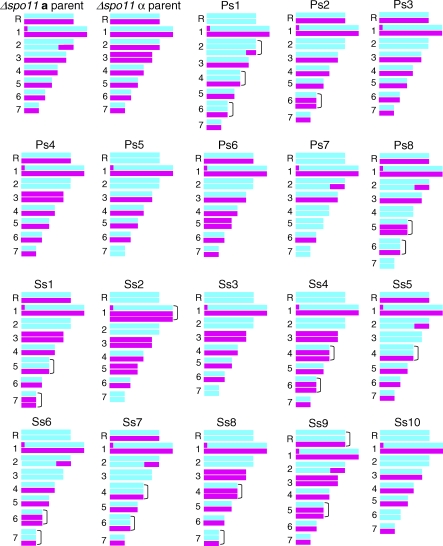
Schematic Summary of Genomic Profiles of Progeny Diploid Strains Derived from the Δspo11 Tetraploid Strain via the Parasexual CycleProgeny strains were analyzed by SNP and CGH microarrays to determine the genetic content of each strain. As described in the legend to Figure 4, chromosome homologues are indicated by blue and pink bars to represent “maternal” and “paternal” homologues, respectively. In cases where a chromosome is trisomic, this is indicated by a bracket to the right of the chromosome. Ps1 to Ps8 progeny strains were derived from growth of the Δspo11 tetraploid (RBY176 or RBY177) on pre-spo medium, while Ss1 to Ss10 strains were derived from Δspo11 tetraploid growth on sorbose medium. Detailed SNP and CGH array data are provided in Tables S5 and S6 and Figure S4.